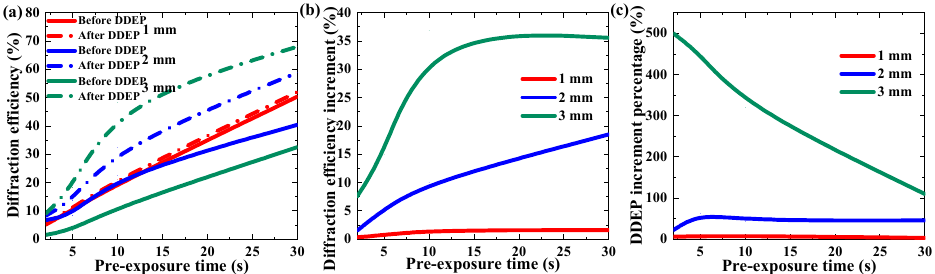
Figure 5. Effect of pre-exposure time on the DDEP of materials with different thickness: ( a ) maximum diffraction efficiency, ( b ) diffraction efficiency increment, ( c ) DDEP increment percentage.